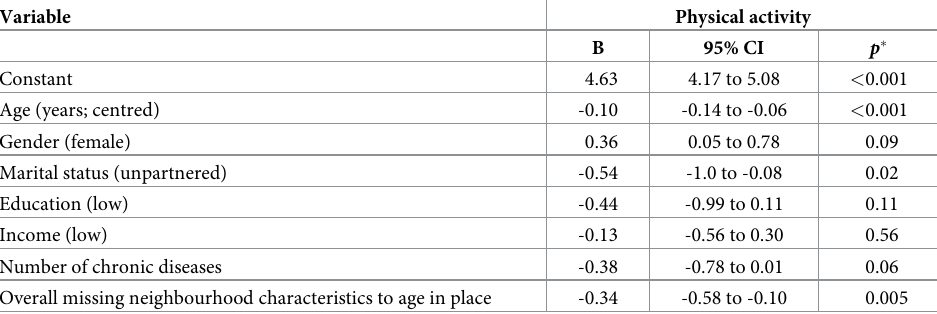
Table 3. Associations of participant and neighbourhood characteristics to age in place with physical activity, as determined by multilevel analysis.